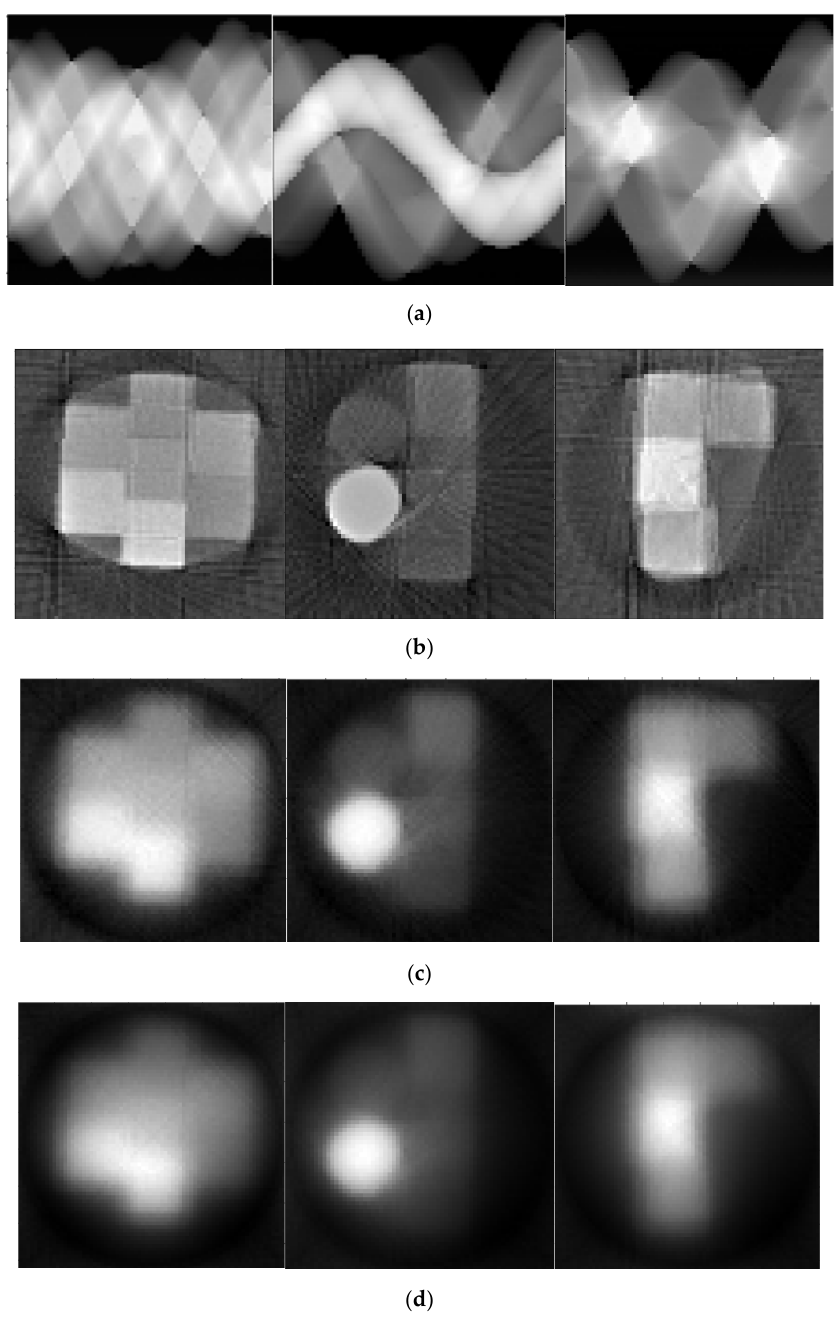
Figure 7. ( a ) Sinograms of all specimens by FBP and reconstructed CT images of all specimens by FBP ( b ), ART ( c ) and ML-EM ( d )